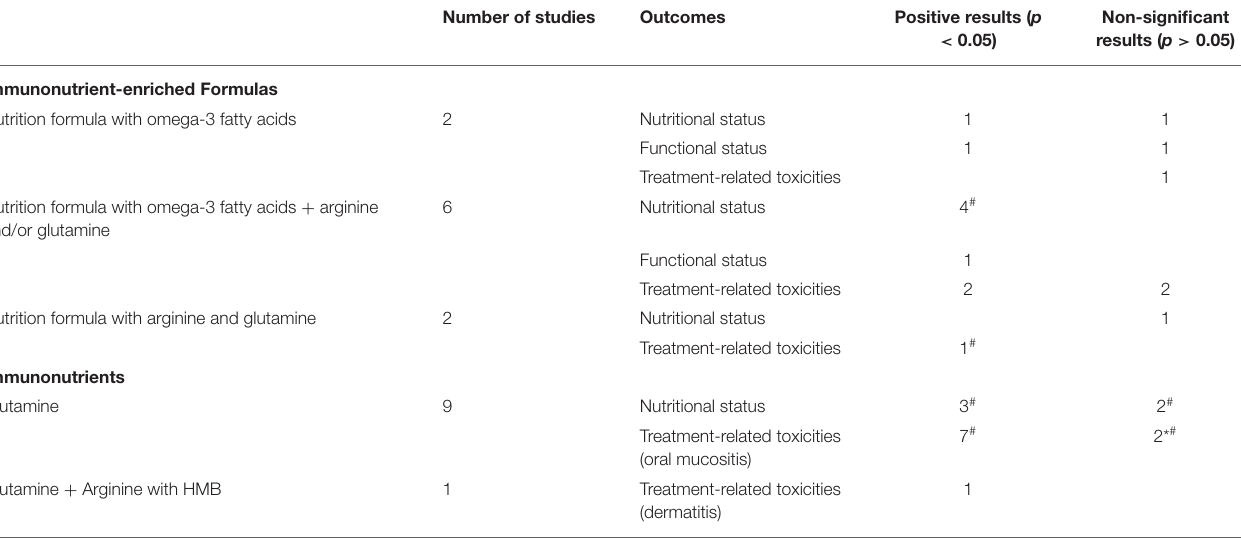
TABLE 5 | Summary of results according to types of formulas or immunonutrients.